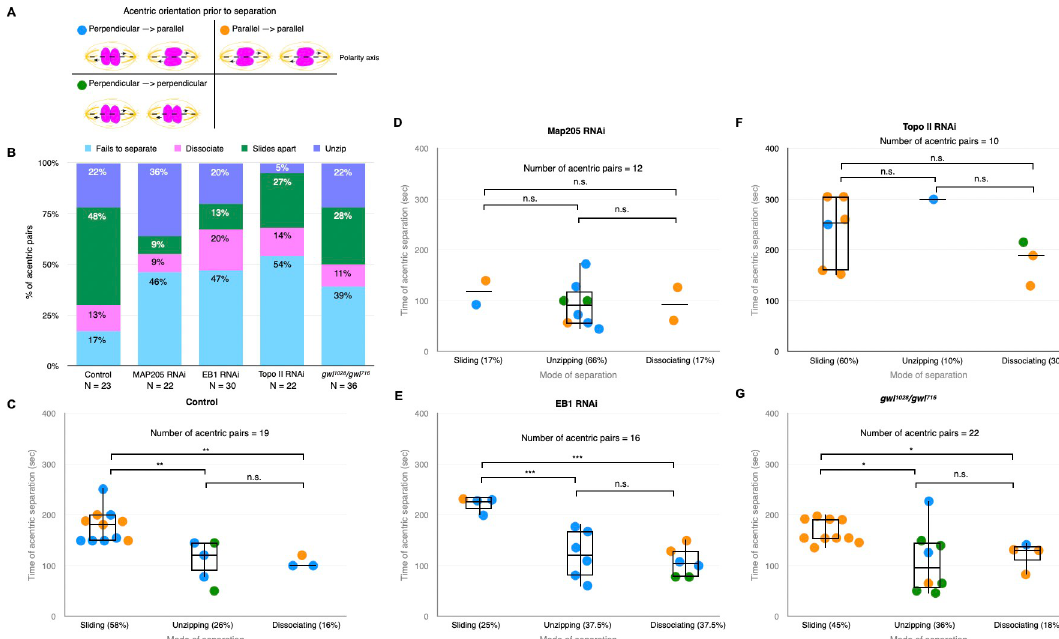
Fig 5. Knockdowns of EB1 and Map205 preferentially disrupt the sliding mode of acentric separation. (A) Model of different acentric orientations prior to separation. Polarity axis indicated by the dotted line. (B) Bar graph showing the percentage of acentric pairs that separate via simultaneous dissociation, sliding, or unzipping and the percentage of those that fail to separate. (C-G) Measurements of the frequency of each mode of acentric sister separation (x-axis) and the timing of acentric sister separation after the separation of intact chromosomes (y-axis). Each dot represents one acentric pair. Blue dots represent acentric pairs that were oriented perpendicular then parallel to the polarity axis prior to separation. Orange dots represent acentric pairs that were oriented parallel to the polarity axis prior to separation. Green dots represent acentric pairs that were oriented perpendicular to the polarity axis prior to separation. Boxes show interquartile ranges and lines show medians of the measured data. Asterisks indicate statistical significance ( � P = 0.01, �� P = 0.005, ��� P = 0.009) when comparing the timing of acentric separation between separation modes. Statistical analysis was done using two-sided Mann-Whitney tests. Non-significant values had a P-value greater than